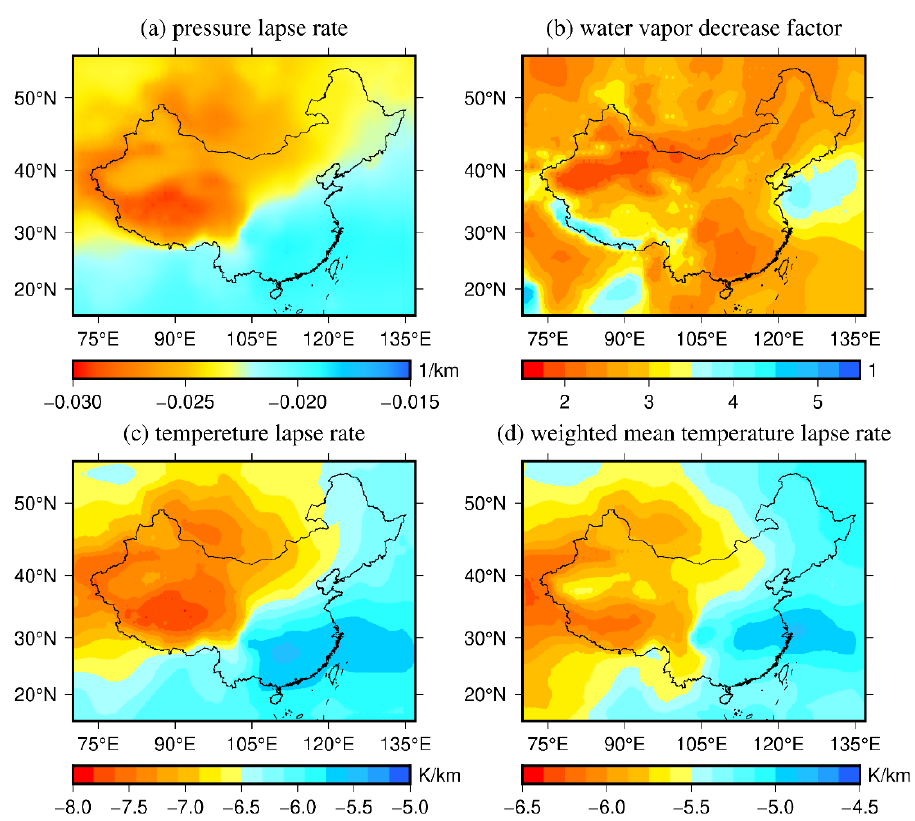
Figure 5. Distribution of the annual mean of the lapse rate for pressure ( a ), decrease factor for water vapor pressure ( b ), lapse rate for temperature ( c ), and lapse rate for T m ( d ).